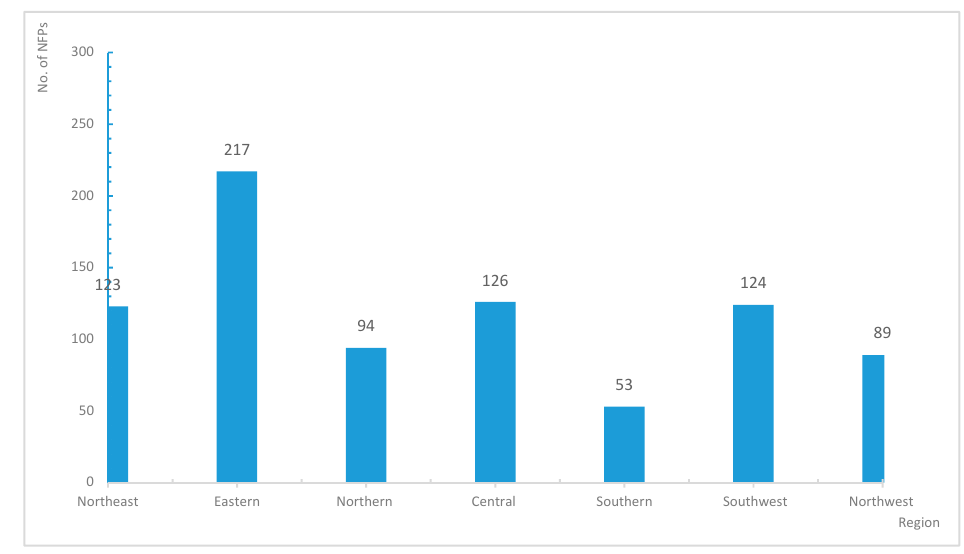
Figure 5. The number of NFPs in 7 regions (status by the end of 2015). (Information collected from the official website of NFGA (http://www.forestry.gov.cn/)).